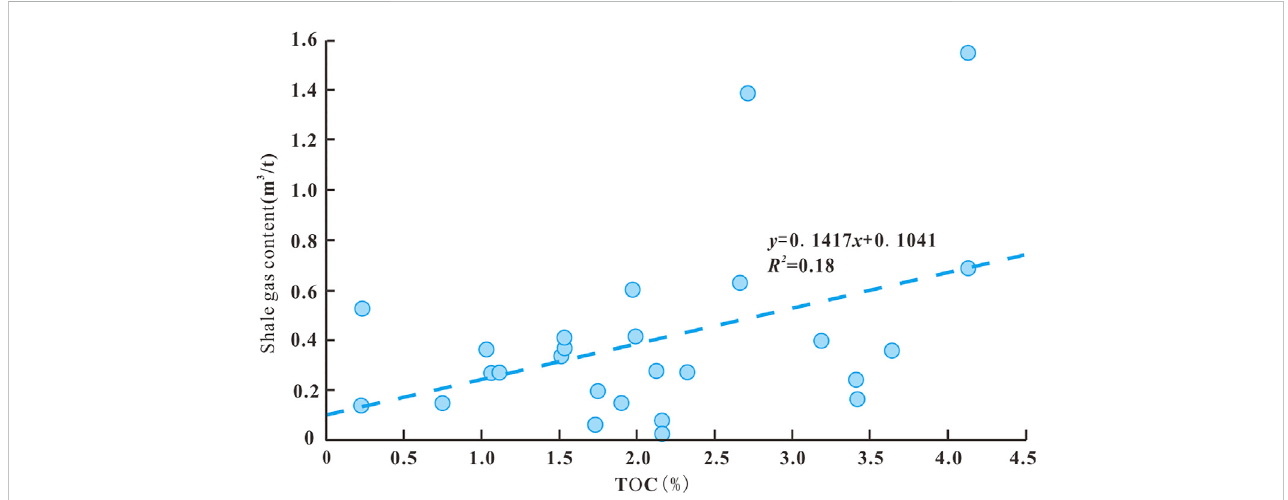
FIGURE 7 Linear relationship between the SG and TOC contents in the western Shandong coal-bearing area Li et al., 2021.